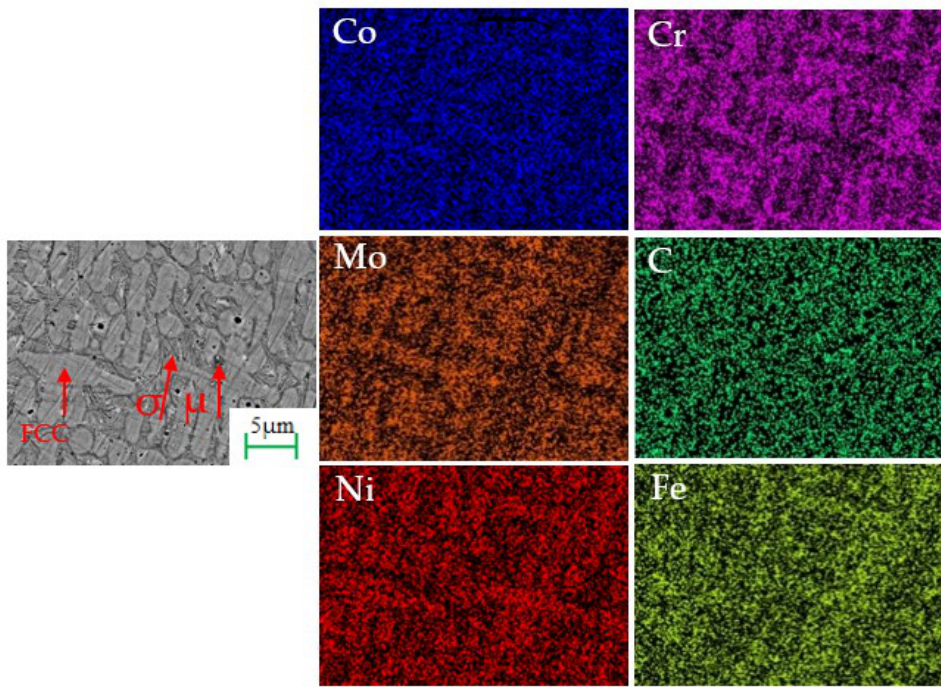
Figure 7. EDS mapping of CoCrNiMo 3 composite coating.